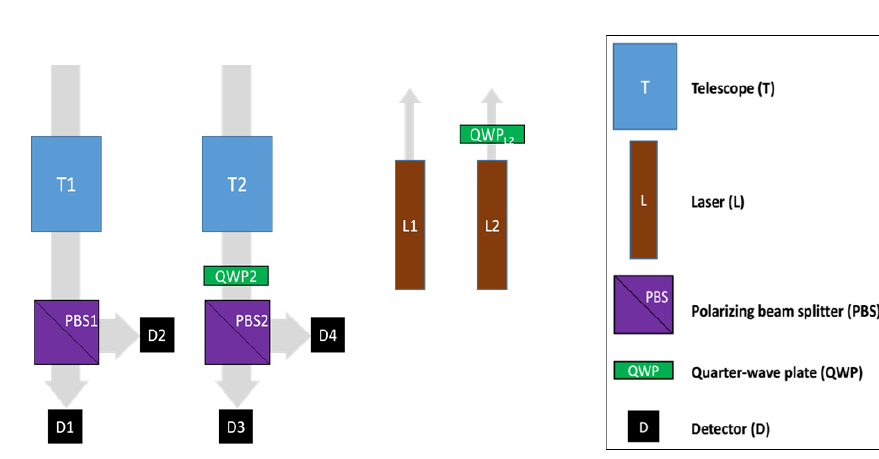
Figure 1: The polarizing lidar